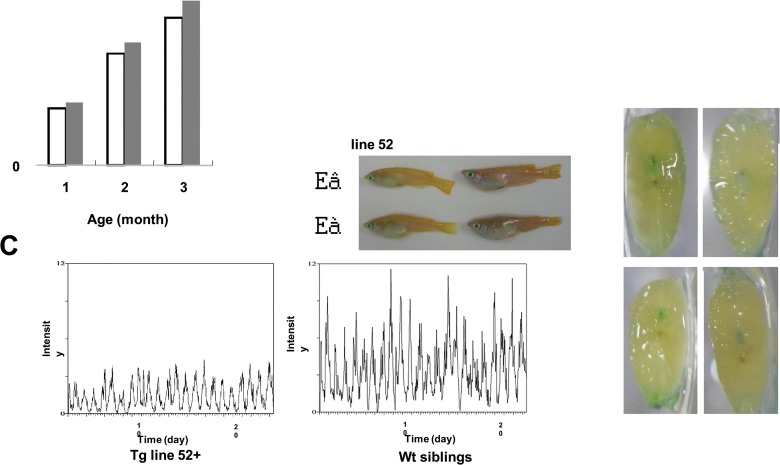
Aging is accelerated in HHM transgenic medaka.(A) The body lengths of line 52 HHM Tg medaka and control non-transgenic Tg siblings were measured after 1, 2 or 3 months rearing under standard conditions. *, p<0.05. (B) Differential appearances of the line 52 HHM Tg medaka (red arrows) and their non-transgenic siblings (black arrows) examined in (A) at one year after birth, shown both in (top) and out (bottom) of the water. Line 52 HHM Tg medaka at one year of age exhibited the prominently hunched back. (C) Representative actogram of a Line 52 HHM Tg medaka and their non-transgenic siblings. (Top) non-transgenic siblings (bottom) line 52 HHM Tg medaka (D) SA-β-galactosidase staining of cross-sections of the bodies of line 52 HHM Tg and non-transgenic Tg medaka siblings. Black arrows indicate the spinal cord. Results are representative of 5 fish examined per group.